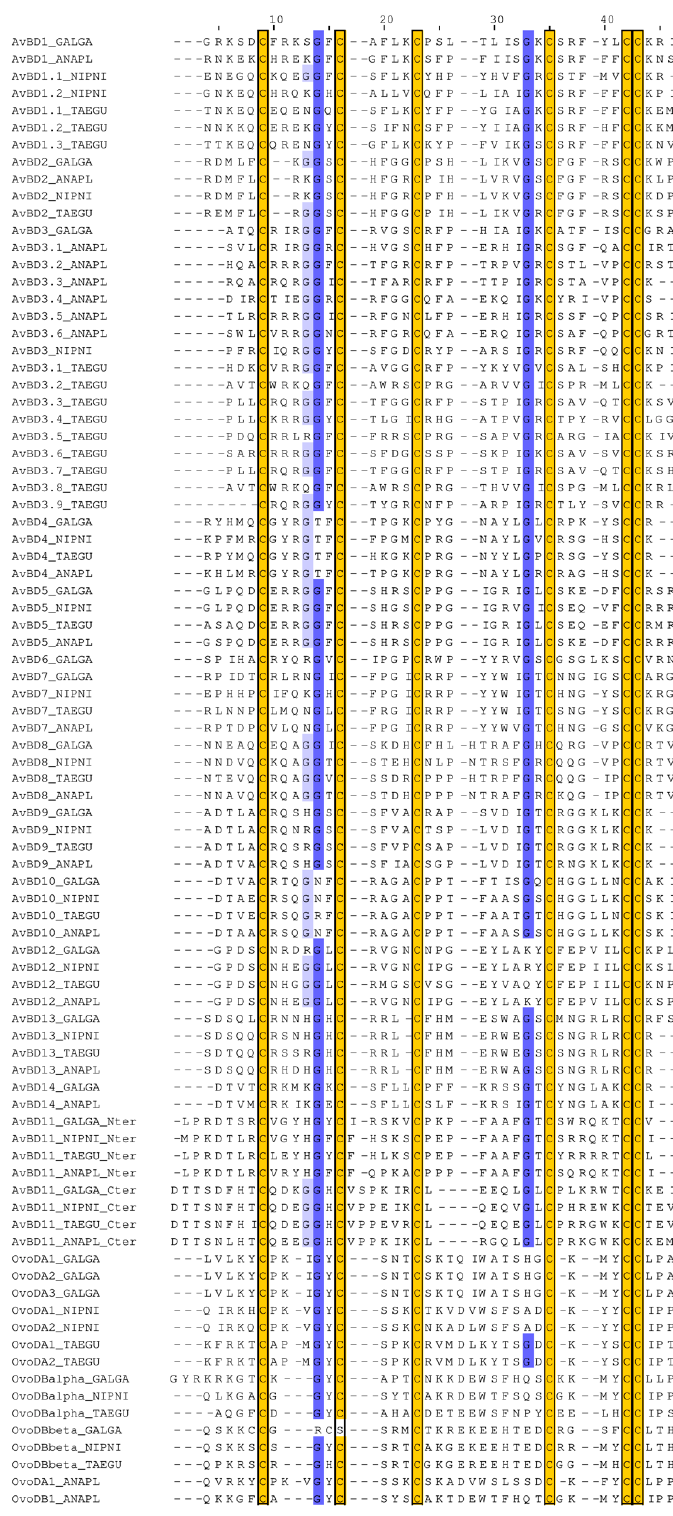
Figure 3. MSA of N-terminal and C-terminal domains of AvBD11 with monodomain AvBDs and OvoDs. MSA was performed with MAFFT and drawn with Jalview with a blue colour gradient (100% of identity for dark blue) and trimmed at each extremity to adjust to the length of the N-terminal and C-terminal domains of AvBD11. Conserved cysteine residues are highlighted in yellow boxes. ANAPL, Anas platyrhynchos (duck); GALGA, Gallus gallus (chicken); NIPNI, Nipponia nippon (crested ibis); and TAEGU, Taeniopygia guttata (zebra finch).